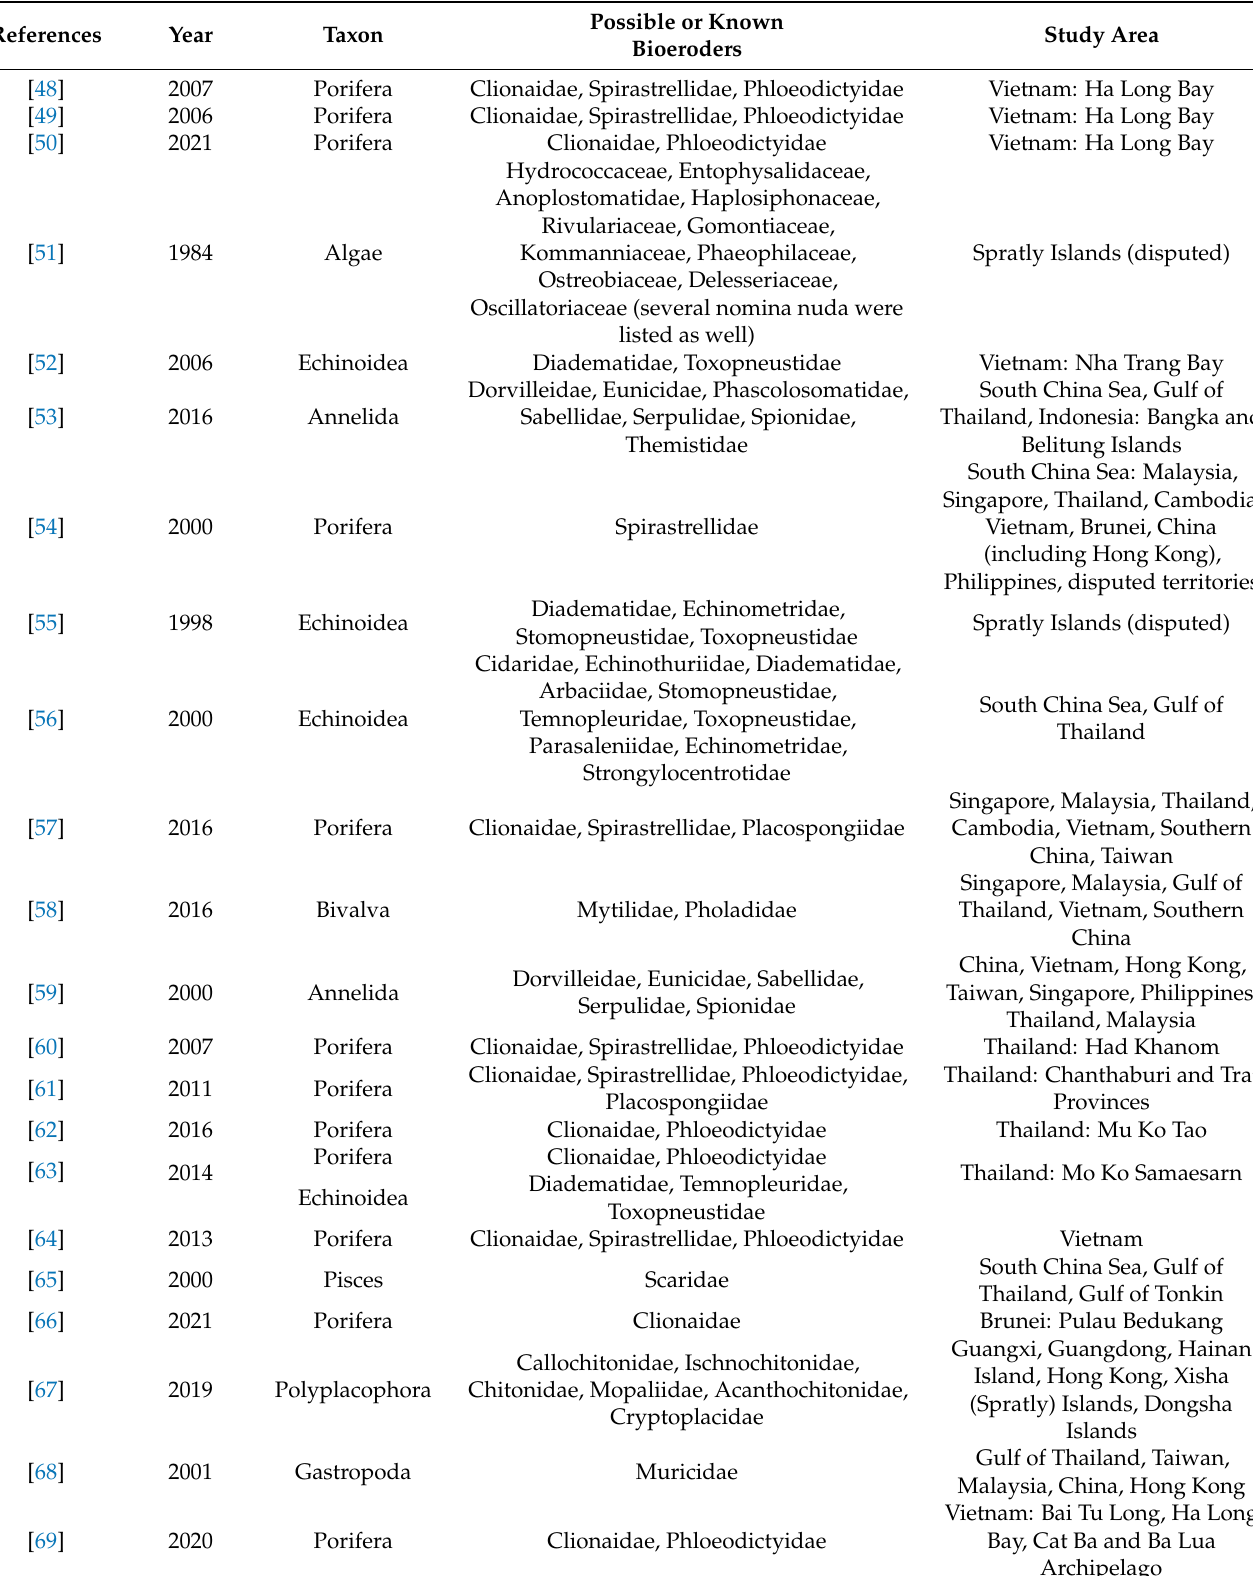
Table 1. Faunistic checklists containing information on bioeroders in the South China